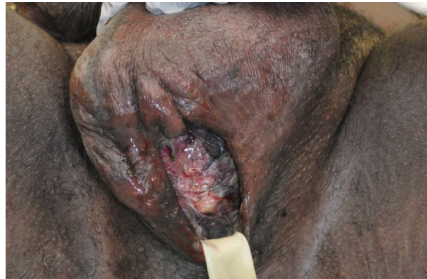
Figure 3: Photographic image of the necrotic tissue of the scrotum with a Penrose drain inserted after an inadequate